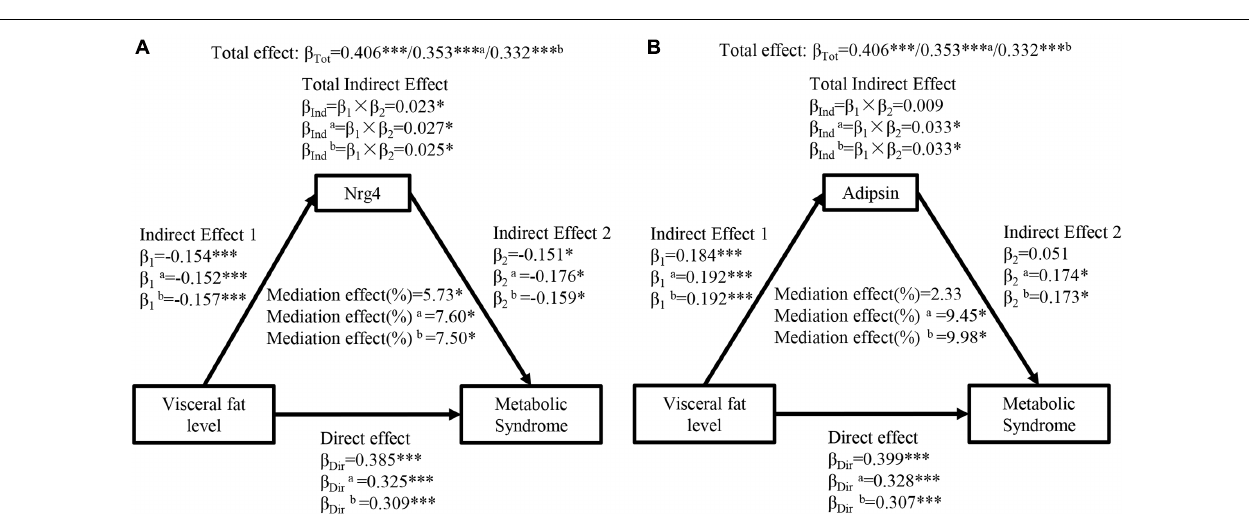
FIGURE 2 | Ngr 4 and adipsin mediate the effect of visceral fat level on metabolic syndrome. (A) Mediation analysis of Nrg4. (B) Mediation analysis of adipsin. β , standardized regression coefficient;